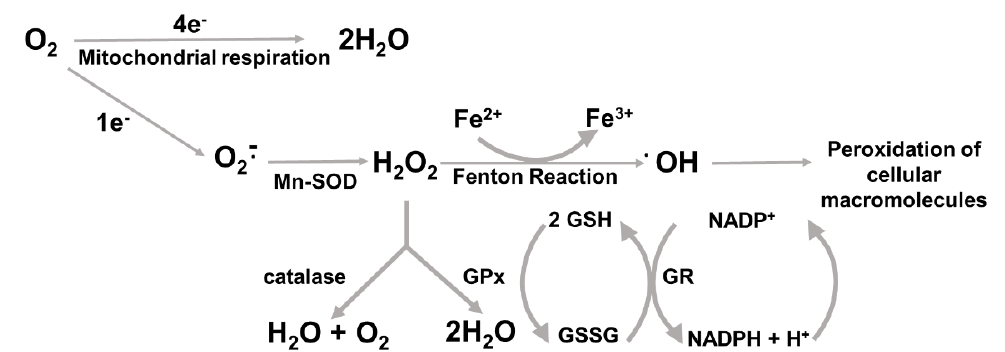
Figure 2. Major sources and reactions underlying the generation of ROS and the early cytoprotective systems detoxifying ROS. Mn-SOD, manganese-dependent superoxide disutase; GSH, reduced glutathione; GSSG, glutathione disulfide; GPx, glutathione peroxidase; GR, glutathione reductase; NADP+/NADPH, oxidized/reduced nicotinamide adenine dinucleotide phosphate. CLL cells, in contrast with other blood malignancies that produce ROS through en- hanced activity of NOXs, with a metabolic shift to aerobic glycolysis (“Warburg effect”) [79], have been shown to express low levels of the catalytic subunit (gp91phox) of NOX2, the most representative NOX2 in myeloid and lymphoid cells [25], displaying increased oxidative phosphorylation (OXPHOS) [21,80]. The substantial electron leakage that results which triggers the expression of factors, such as of HO-1 [81], that promote de novo mito- chondrial biogenesis [22], and enzymes directly involved in the GSH synthesis, such as GCL and G6PDH, resulting in a higher amount of thiols relative to normal B cells [26,82].